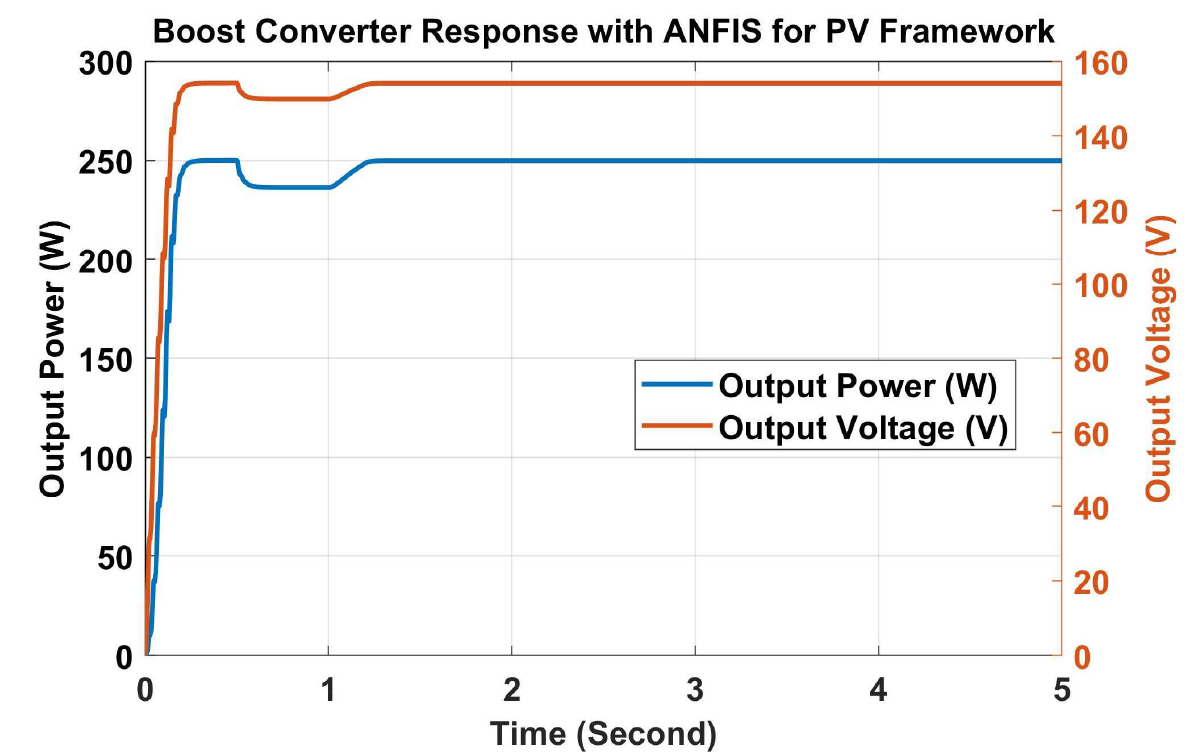
Figure 31. Output Power and Voltage of Boost Converter with AN-FIS MPPT for PV